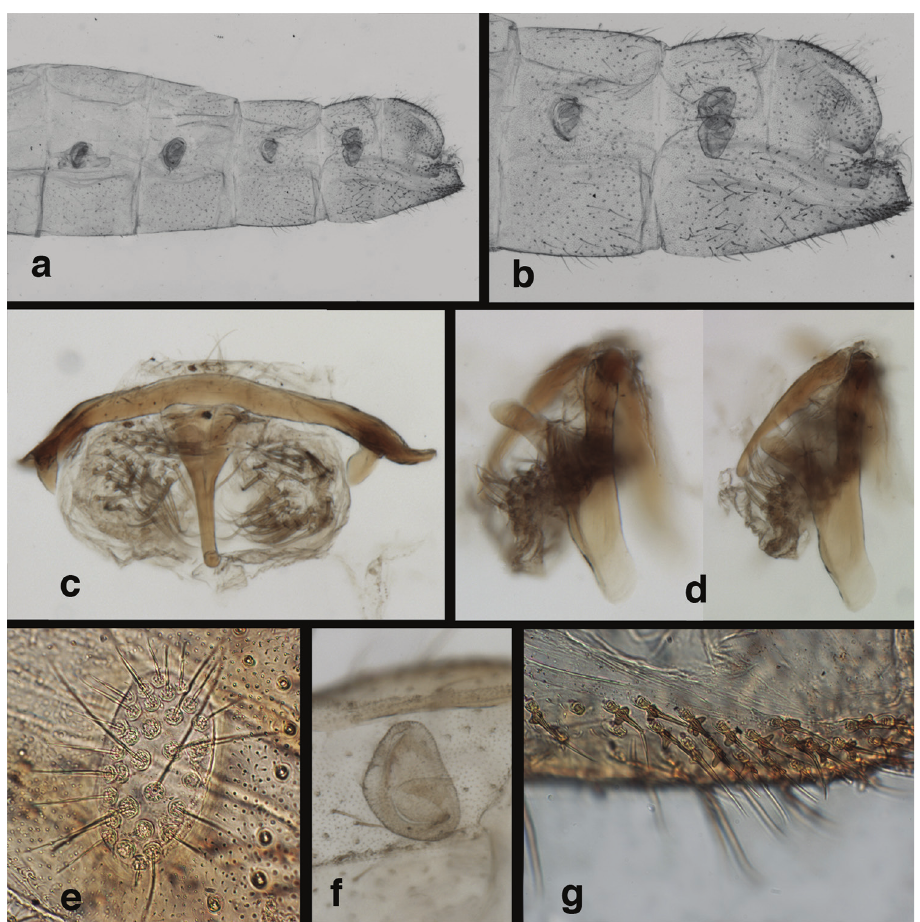
Figure 112. Chrysopa metanotalis Navás: Male abdomen and genitalia, ( a ) segments A5-terminus, lateral ( b ) segments A7-terminus, lateral ( c ) gonarcal complex, dorsal ( d ) gonarcal complex, left: posterolateral, right: lateral ( e ) callus cerci ( f ) spiracle, A8 ( g ) enlarged, flanged setae on distolateral margin of S9 (Argen- tina, Catamarca, lectotype,